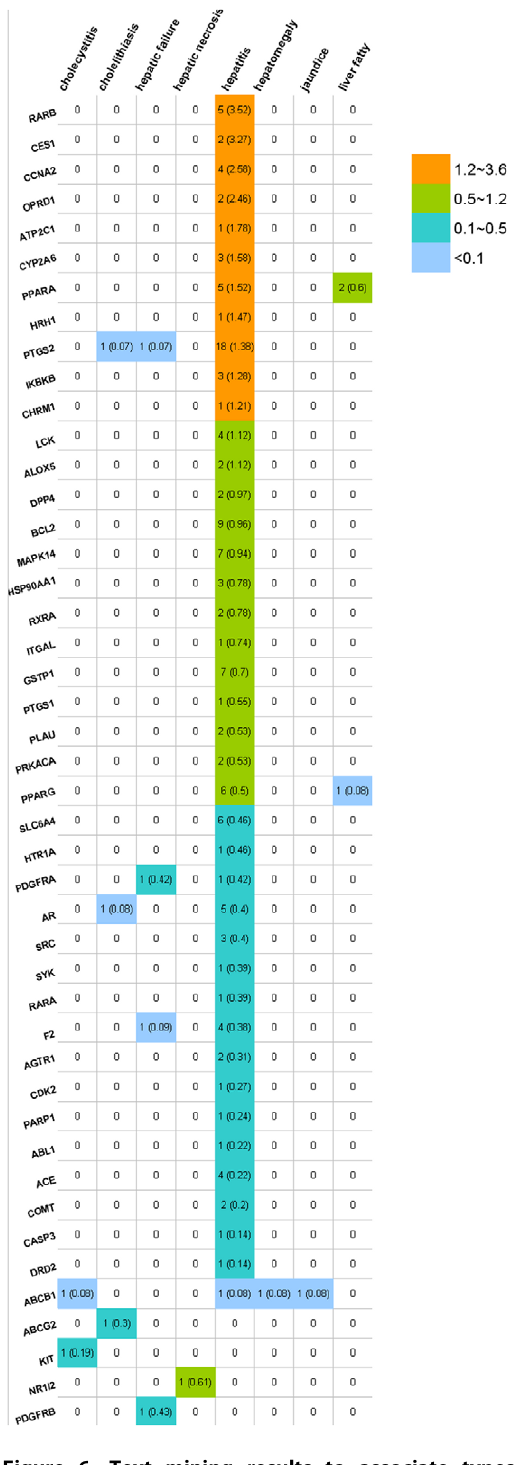
Figure 6. Text mining results to associate types of DILI (columns) with protein targets (rows). The number of co- occurrences (papers) between a target and a side effect type is indicated in the cell. In each cell, the total number of reports as well as the normalized value (shown in parenthesis) is provided. The normalized value is the ratio of the number of co-occurrence reports divided by the total number of reports for a protein target.